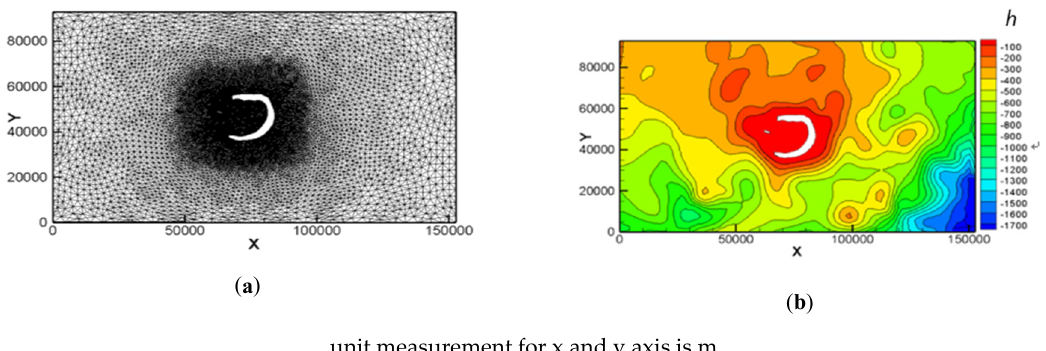
Figure 10. ( a ) Global view of meshes and ( b ) the bathymetry contour of computational domain.